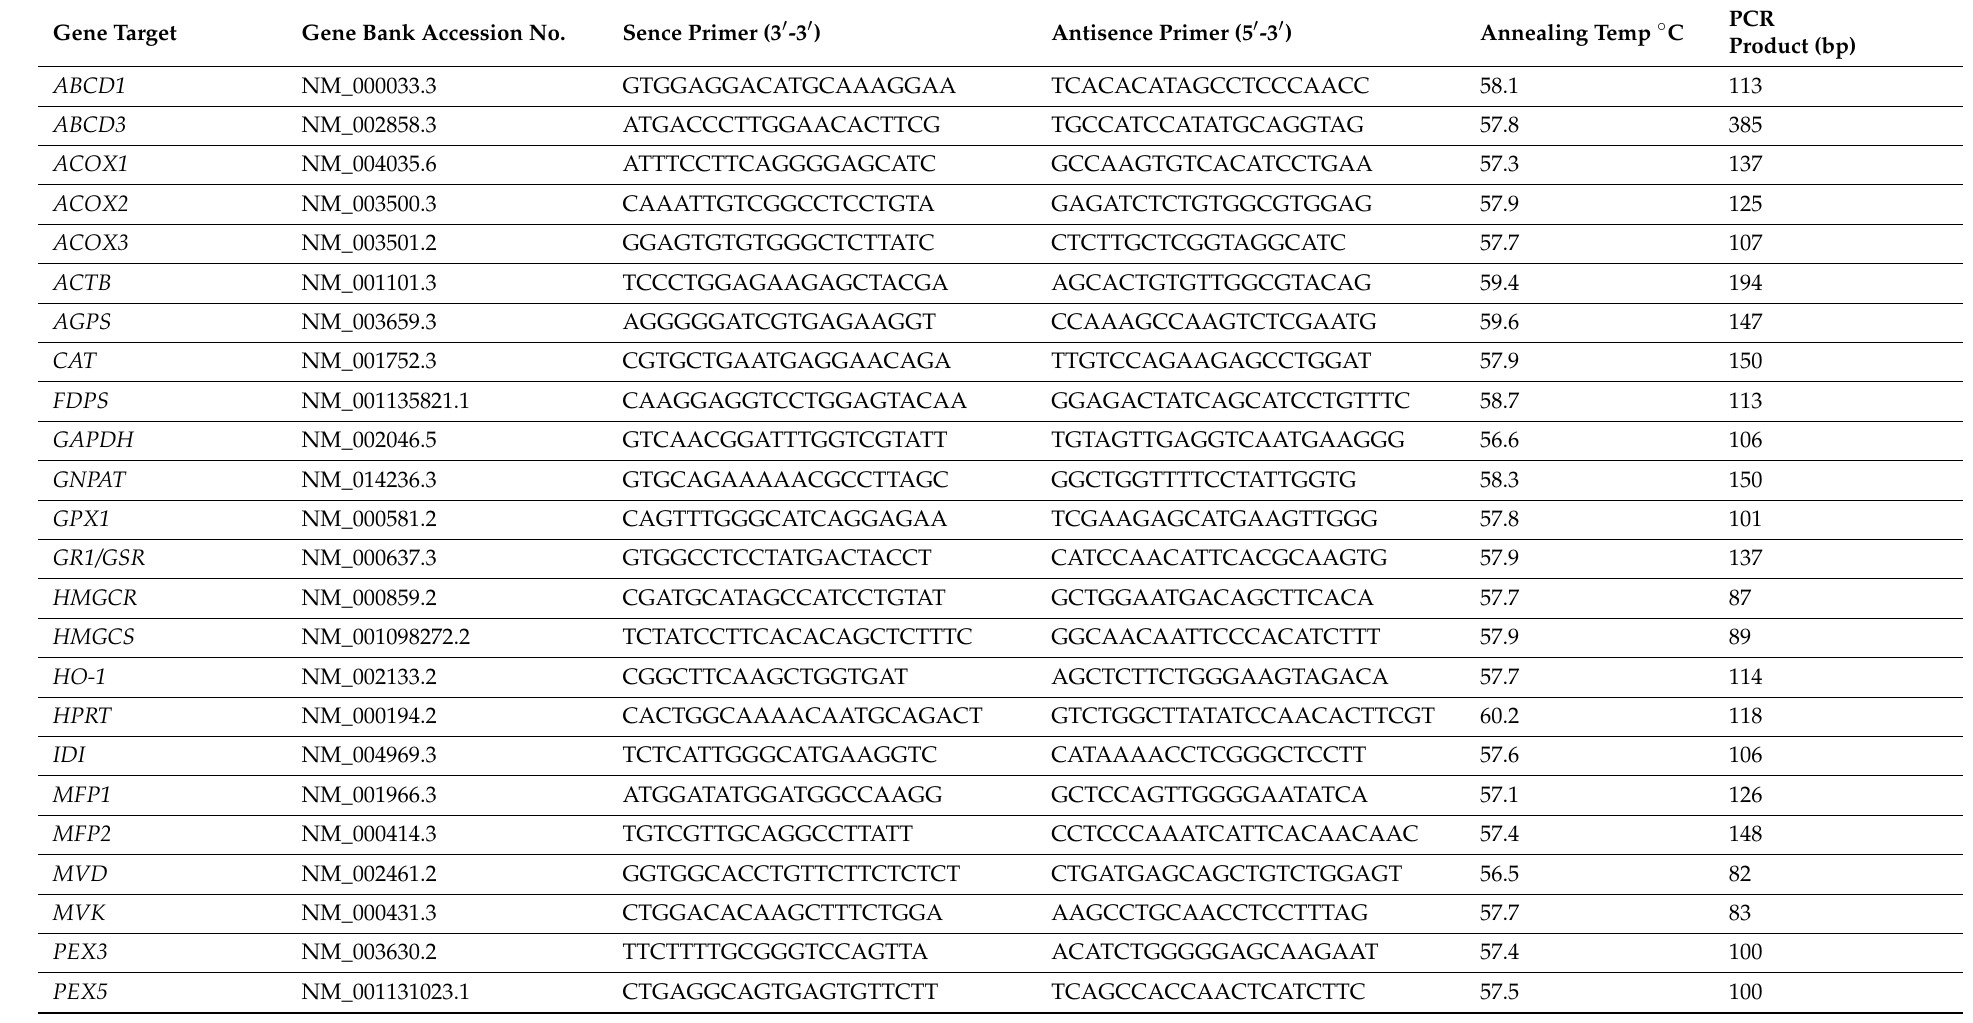
Table 2. List of the human primers used for RT-PCR